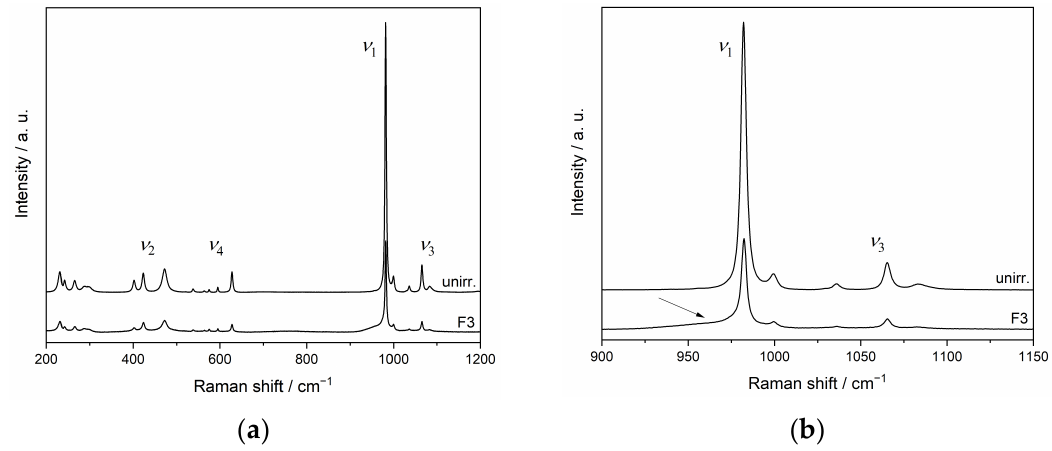
Figure 8. Raman spectra of a pristine SmPO 4 pellet and the pellet irradiated with the highest fluence (F3 = 5.1 × 10 14 ions cm −2 ) (( a ) total spectrum, ( b ) region of stretching vibrations ν 1 and ν 3 ); the arrow indicates a shoulder developing at a wavenumber around 960 cm −1 (Figs. reproduced from [56]).